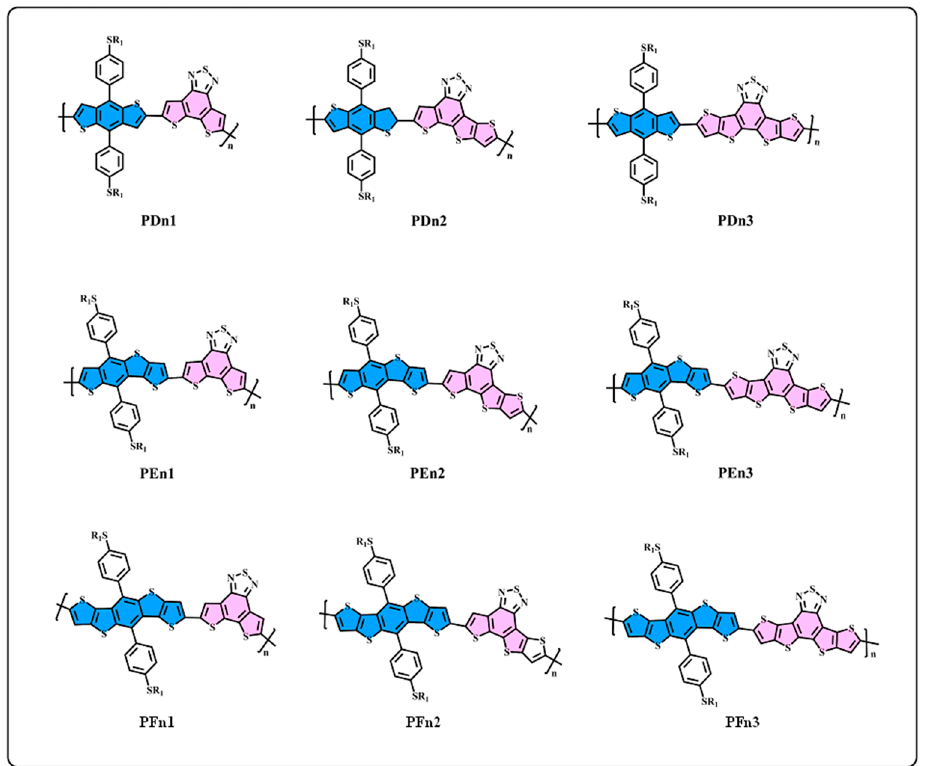
Figure 2. The structure of D–A oligomers: PDn1, PDn2, PDn3, PEn1, PEn2, PEn3, PFn1, PFn2, and PFn3.